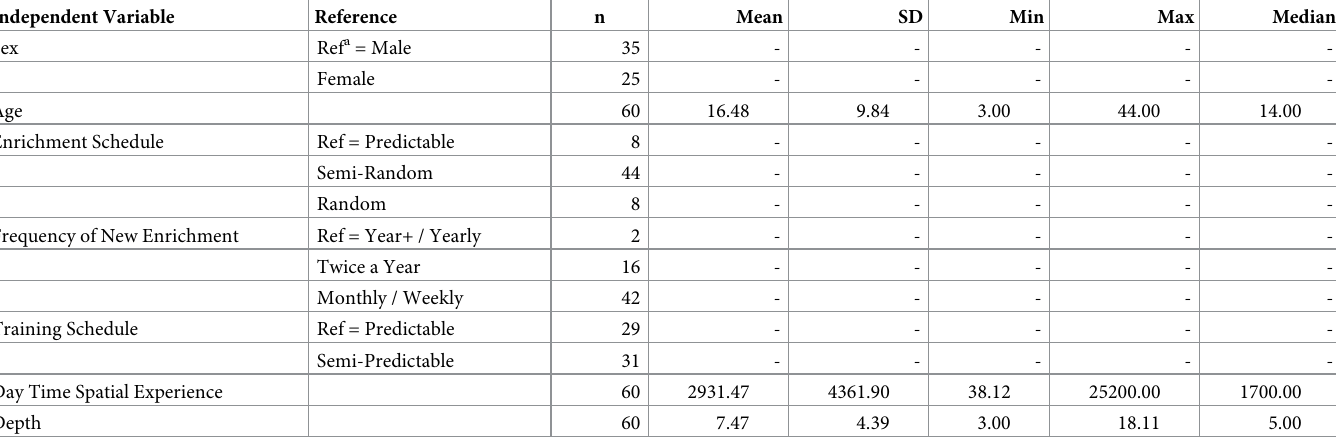
Table 4. Descriptive statistics for the independent variables included in the multivariate modeling process.